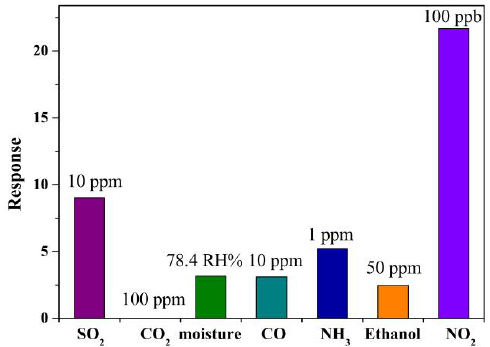
Figure 4. Cross-response of WN/WO 3 composites sensor to various gases.